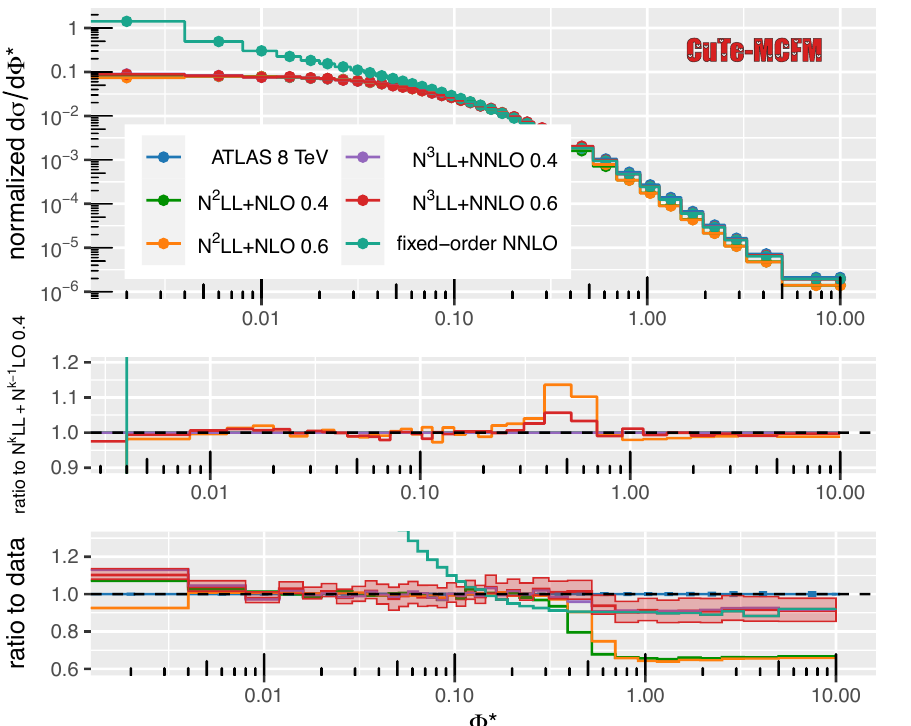
Figure 8. Predicted and measured φ ∗ distribution of the Z boson with fiducial cuts as in the ATLAS study [99] at 8 TeV . The middle panel shows the effect of varying the transition function, while the bottom panel shows the ratio to data with estimated scale